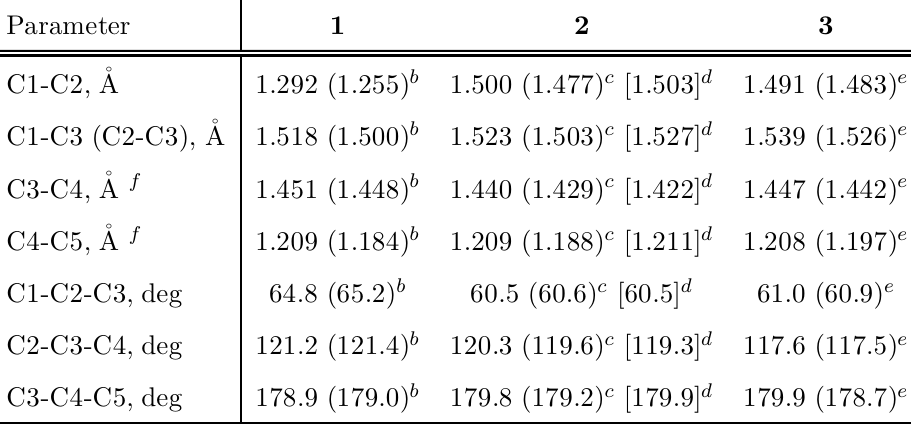
Table 3 Experimental and calculated bond lengths and angles for 1{3 optimized at B3LYP/6- 31G(d) level a